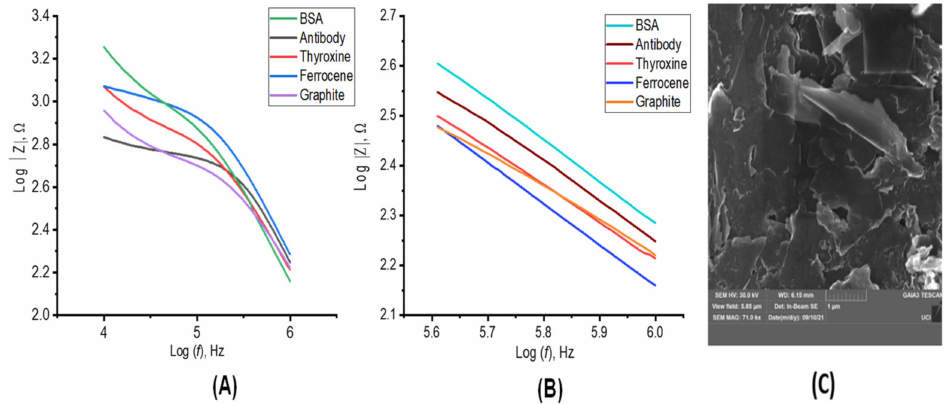
Figure 3. Characterization of pencil graphite electrode. ( A ) Bode plots were obtained using the same conditions as in 2C. ( B ) An amplitude view of the plots in high-frequency regions. ( C ) SEM image of the working electrode after being coated and blocked by antibody and BSA, accordingly, at 71.0 kx